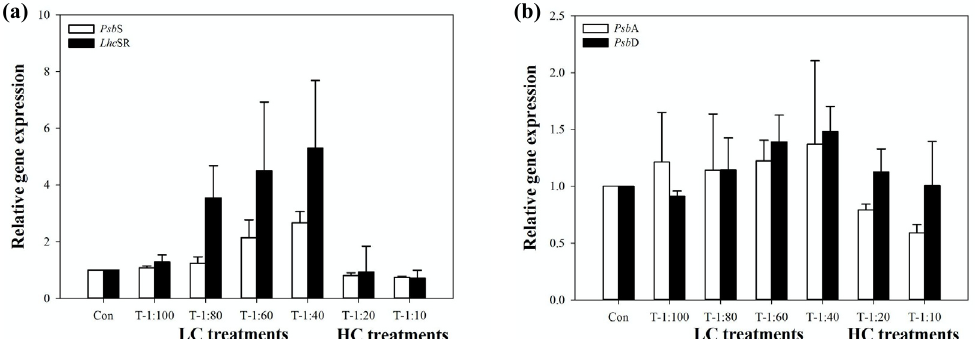
Figure 7. Relative expression of the genes ( a ) Psb S and Lhc SR, and ( b ) Psb A and Psb D of Ulva prolifera under the exposure of different amounts of cell ‐ free filtrate of Bacillus cereus BE23. T 1:100 , and T 1:80 ~T 1:10 indicate the treatments of volume ratio of cell ‐ free filtrate of Bacillus cereus BE23 relative to f/2 medium. Values are means ± SD (n = 3).